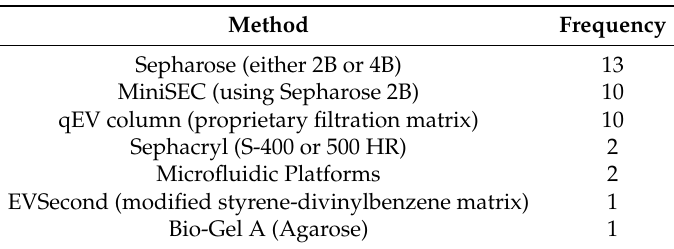
Table 1. Separation methods in brief.